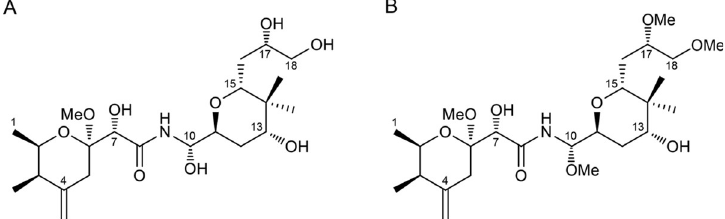
Fig 1. Structures of diaphorin (A) and pederin (B). Diaphorin has hydroxyl groups at C10, C17, and C18, whereas these groups are methylated in